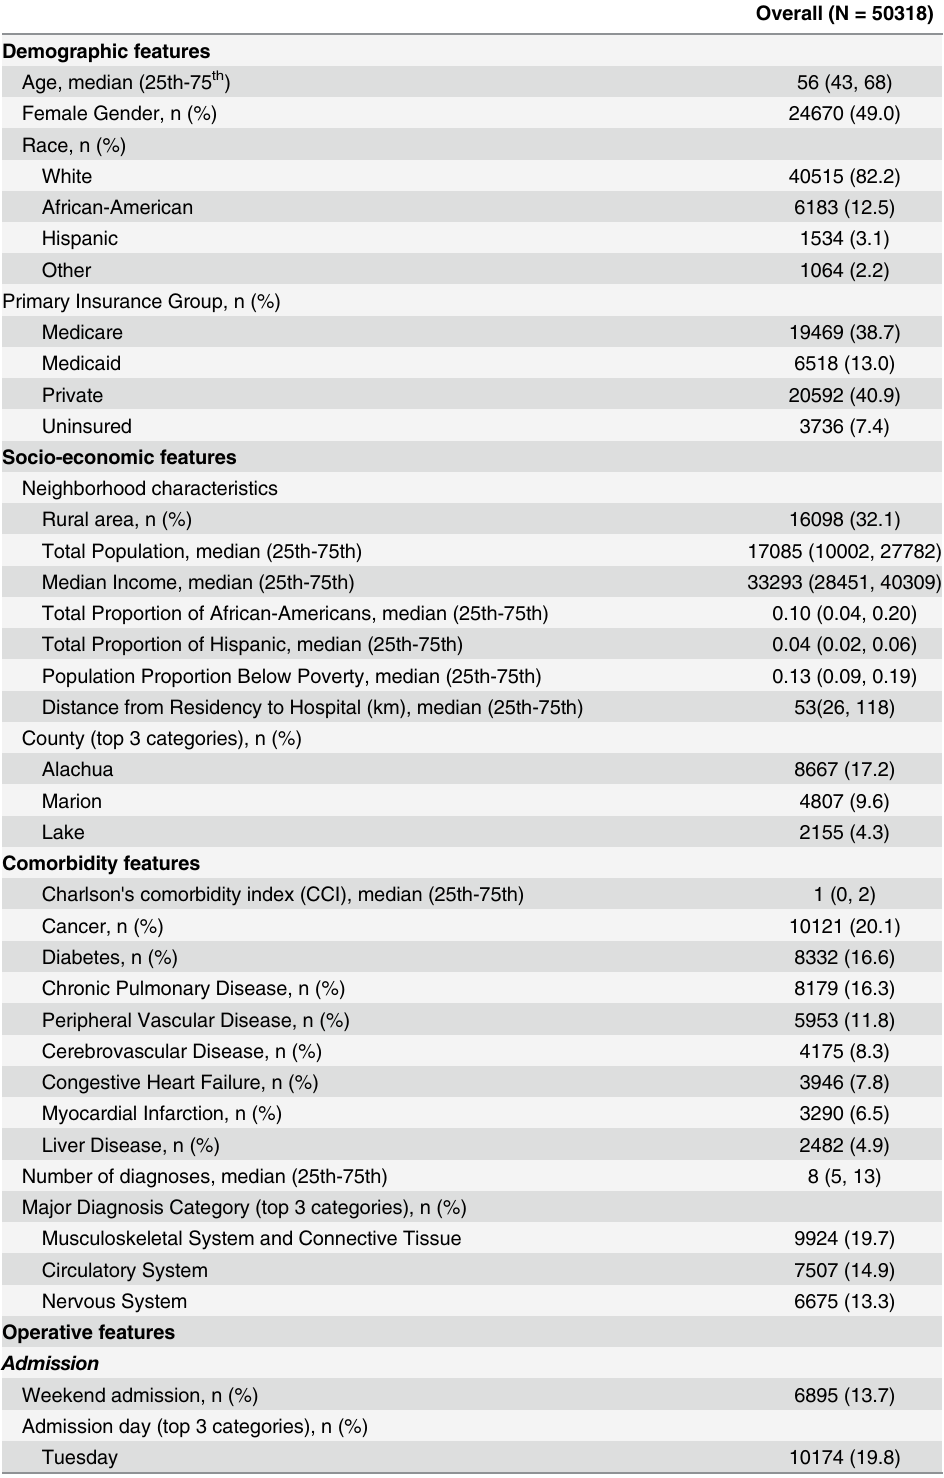
Table 2. Summary of overall cohort. Abbreviations. GFR, Glomerular filtration rate, CBC, complete blood count.